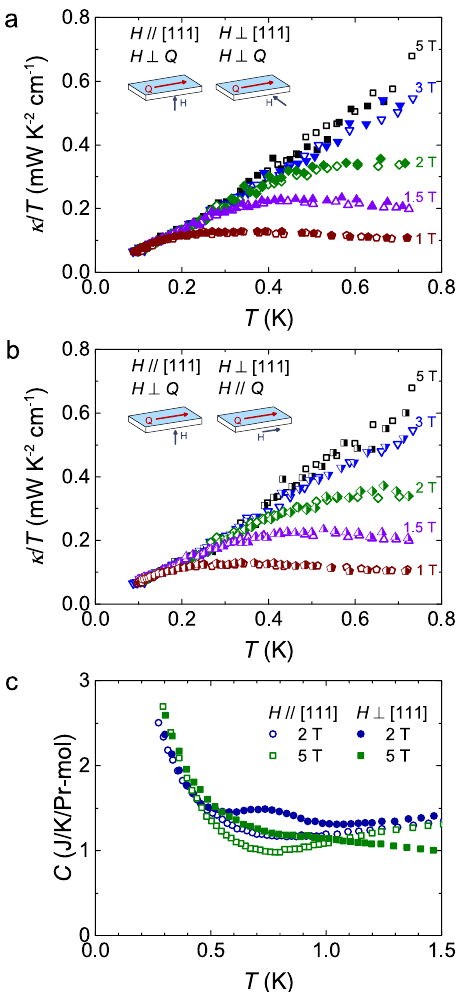
Fig. 4 The giant isotopic magneto-thermal conductivity and anisotropic magneto-speci fi c heat in Pr 2 Ir 2 O 7 . a The thermal conductivities of Pr 2 Ir 2 O 7 single crystal in magnetic fi elds H // [111] and H ⊥ Q (empty symbols) are compared with those in H ⊥ [111] and H ⊥ Q ( fi lled symbols), where Q is the heat current. b They are also compared with those in H ⊥ [111] and H // Q (half- fi lled symbols). The schematic illustrations of these three geometries are also shown. The overlap of these curves in all three fi eld directions show that the MTCs are isotropic. c The speci fi c heats of Pr 2 Ir 2 O 7 in magnetic fi elds H // [111] (empty symbols) are also compared with those in H ⊥ [111] ( fi lled symbols). Contrary to the magneto-thermal conductivities, anisotropy of magneto-speci fi c heats is clearly seen in these two fi eld